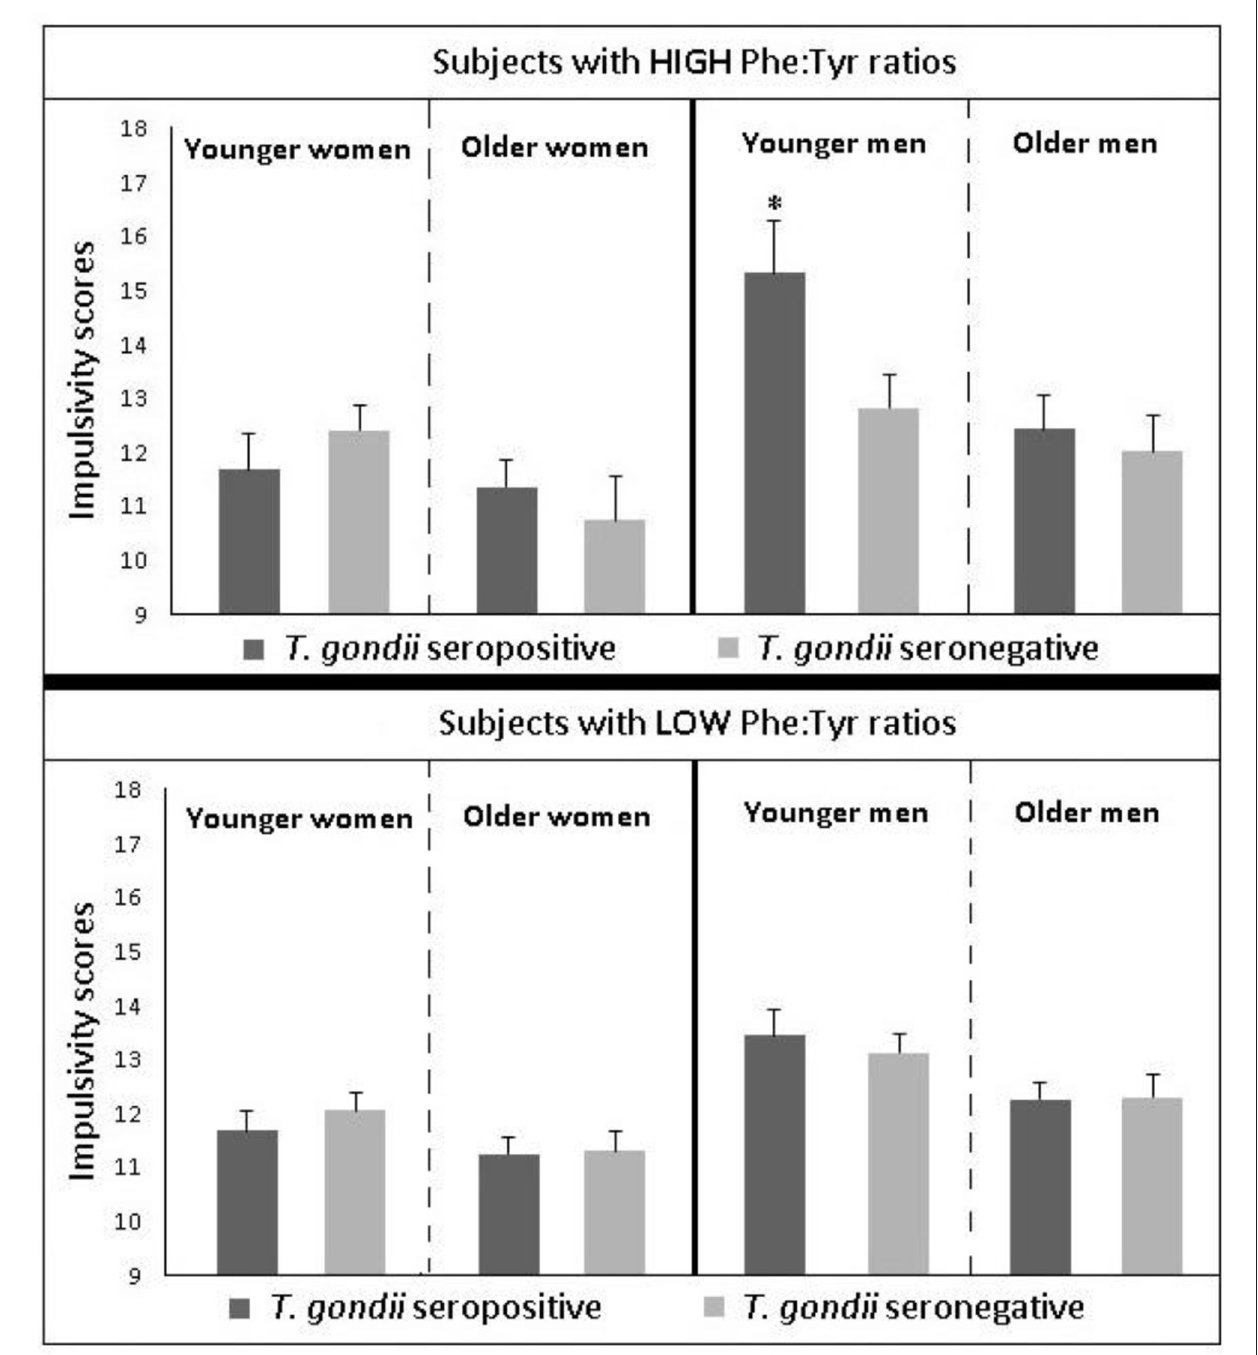
FIGURE 9 | Endophenotypes for suicidal behavior. Comparisons of impulsivity scores between T. gondii IgG-seronegative vs. T. gondii IgG-seropositive individuals and high vs. low phenylalanine/ tyrosine ratio (Phe:Tyr) stratified by gender and groups. Scoring significantly higher on impulsivity scores than other groups required four coexistent criteria, i.e., for a participant to be male, young, T. gondii -positive, and in the upper quartile of Phe:Tyr. Impulsivity scores in seronegative vs. seropositive participants stratified by Phe:Tyr categories, gender, and age. Disinhibition subscale of the Sensation Seeking Scale-V [SSS-V (DIS)] was used to obtain impulsivity scores, which are represented as standard errors (SEs) and least square means (adjusted for age in the age category and stratified by categorical variable). The following strata were included: older women (aged ≥ 60 years), older men (aged ≥ 60 years), younger women (aged 20–59 years), and younger men (aged 20–59 years). If the Phe:Tyr ratio was in the lower 75th percentile, it was considered LOW and if the ratio was in top 25th percentile, it was considered HIGH. Statistically significant interactions were uncovered between T. gondii seropositivity, gender, age category, and Phe:Tyr ratio upon performing ANCOVA analysis of